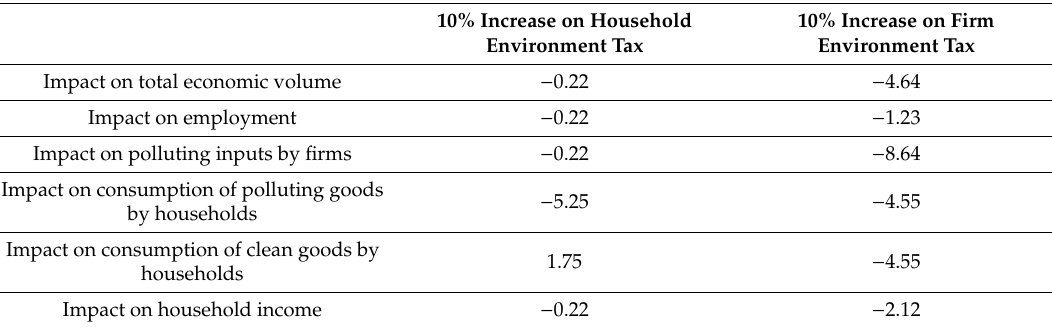
Table 5. Economic e ff ects of 10% increase in environmental taxes (unit: